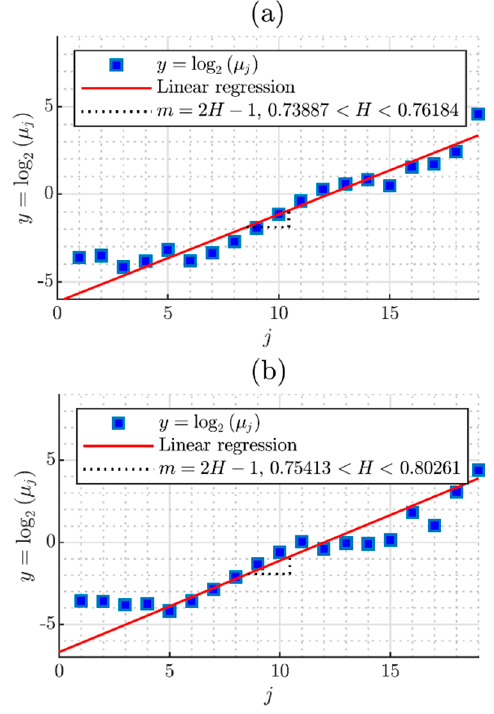
Figure 13. ( a ) LD for a monofractal trace synthesized. ( b ) LD for a synthesized multifractal trace.